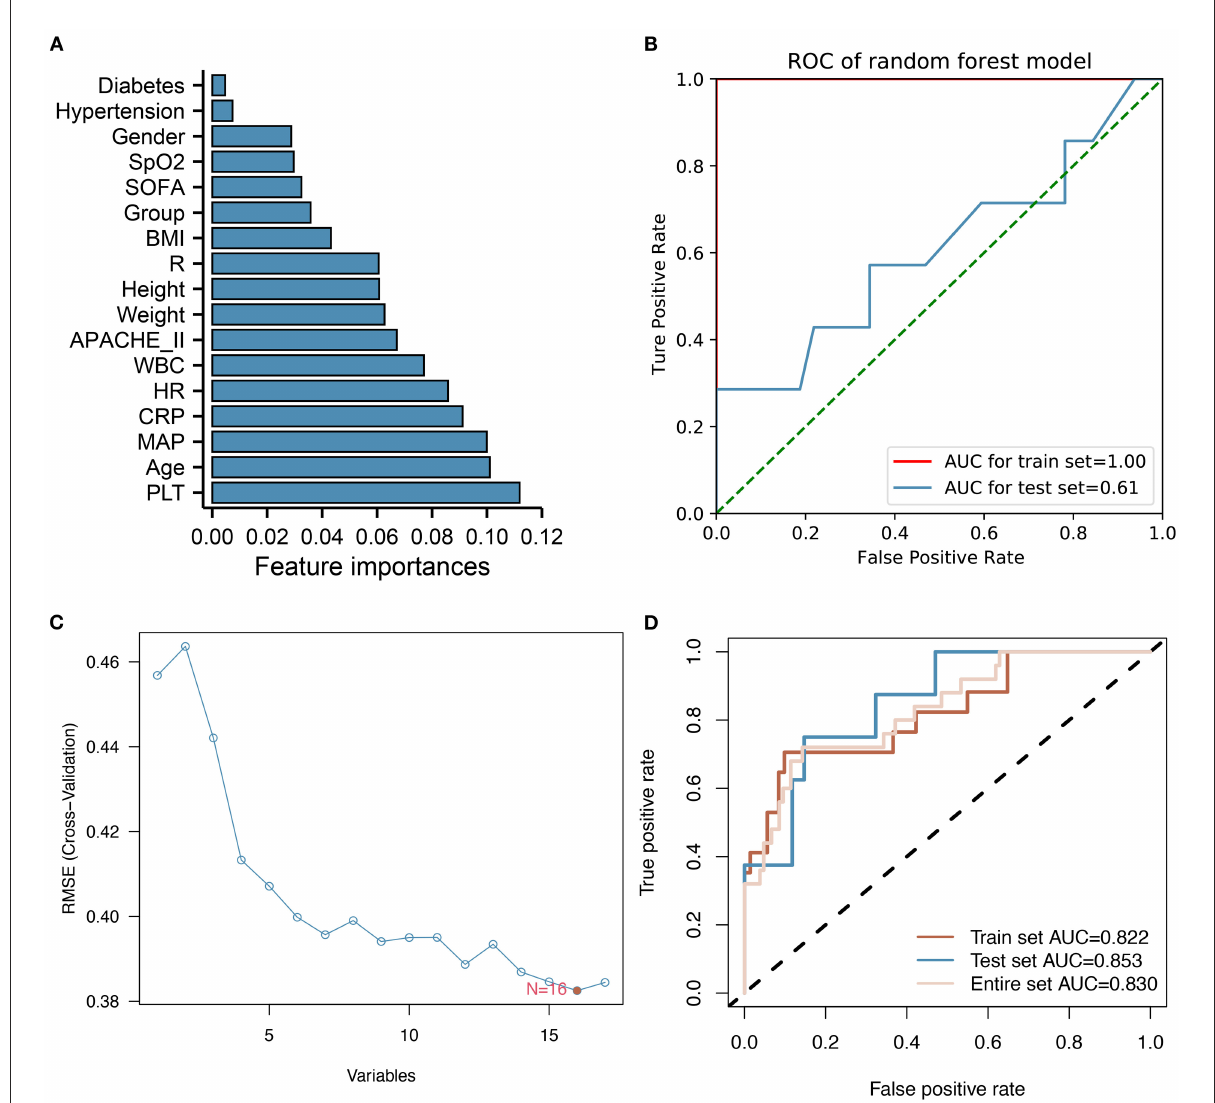
FIGURE1 Feature ranking and filtering process for Random Forest and SVM-RFE models. (A) Bar chart showing a random forest model’s importance ranking of each variable. PLT, age, MAP, CRP, and HR are the top five variables identified. (B) ROC curves showing the classification ability of the random forest model. (C) The feature screening process of SVM-RFE results in the model with the lowest RMSE when 16 variables are selected. (D) ROC curves showing training, test, and overall classification performances of the SVM